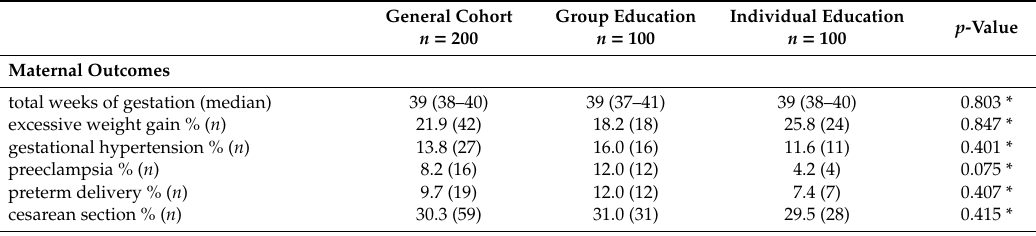
Table 3. Pregnancy outcomes of women in group versus individual